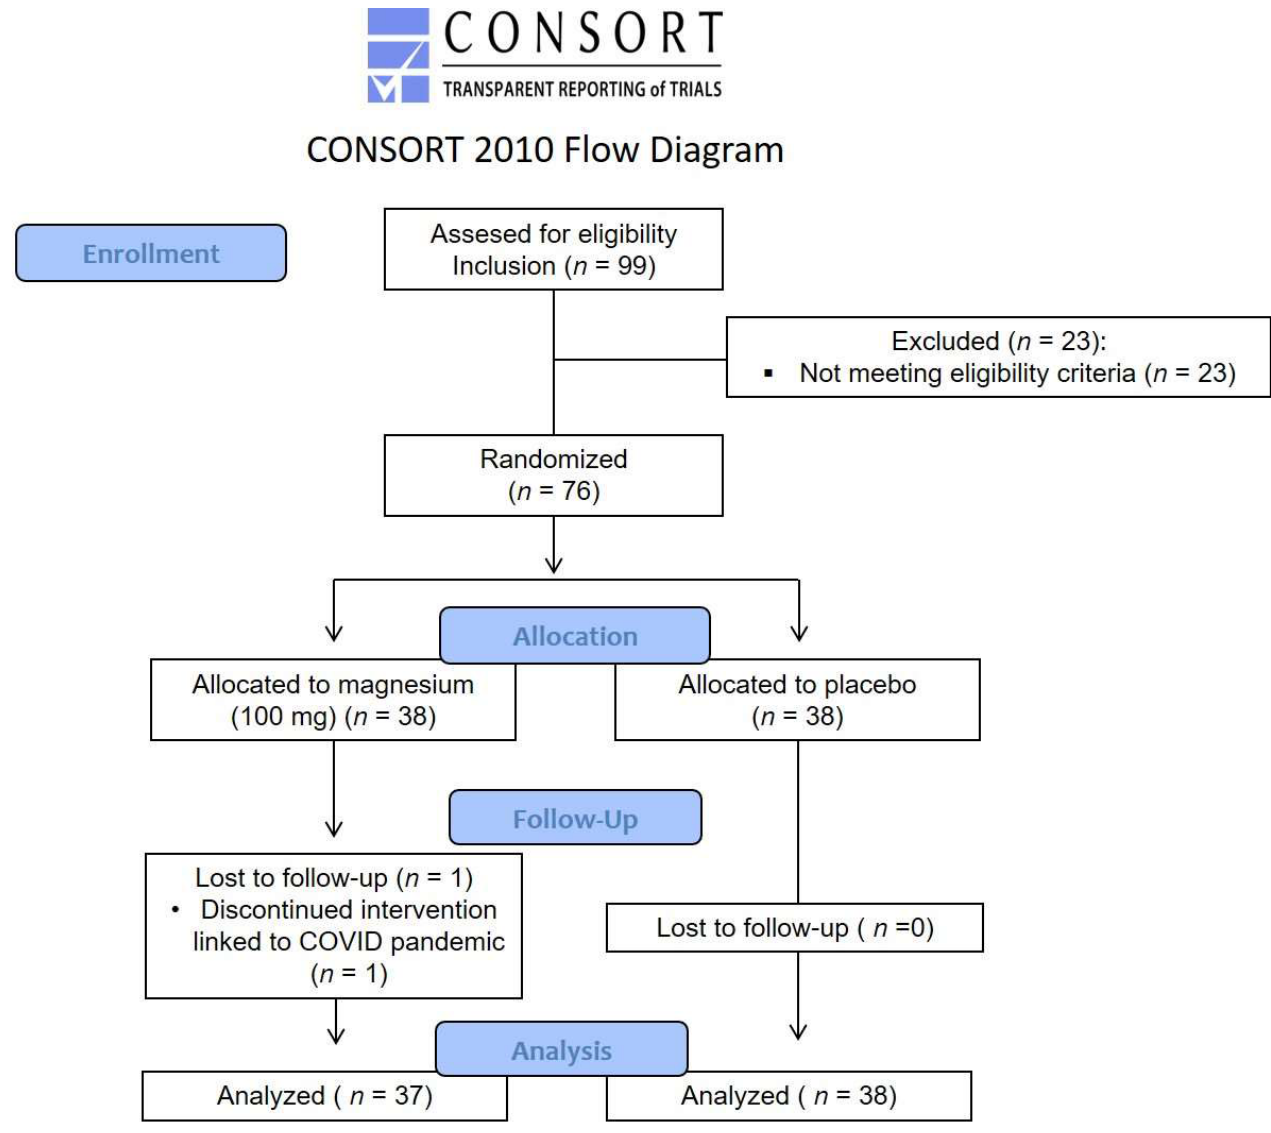
Figure 1. Flow study diagram.